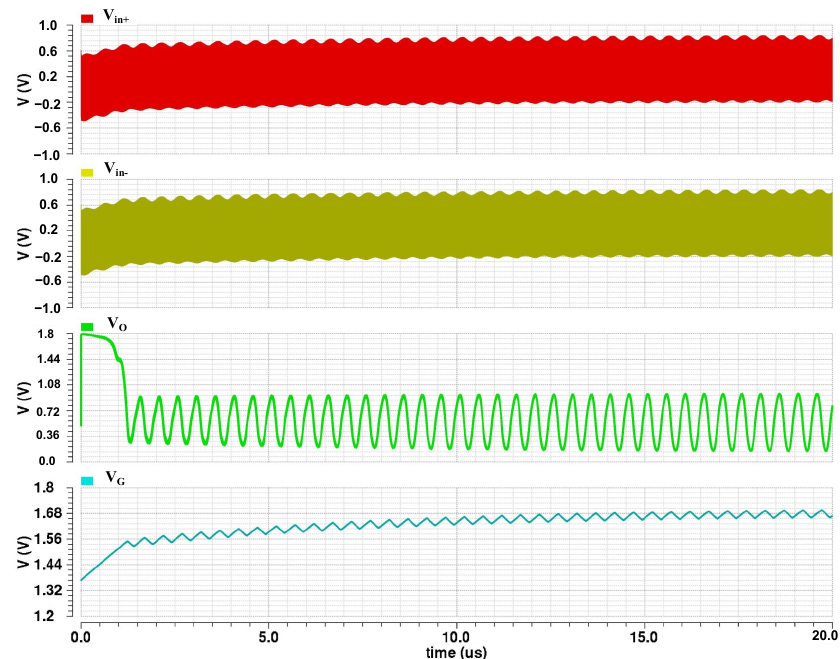
Figure 17. Simulated envelope detector timing waveforms of V in + , V in − , V O and V G .